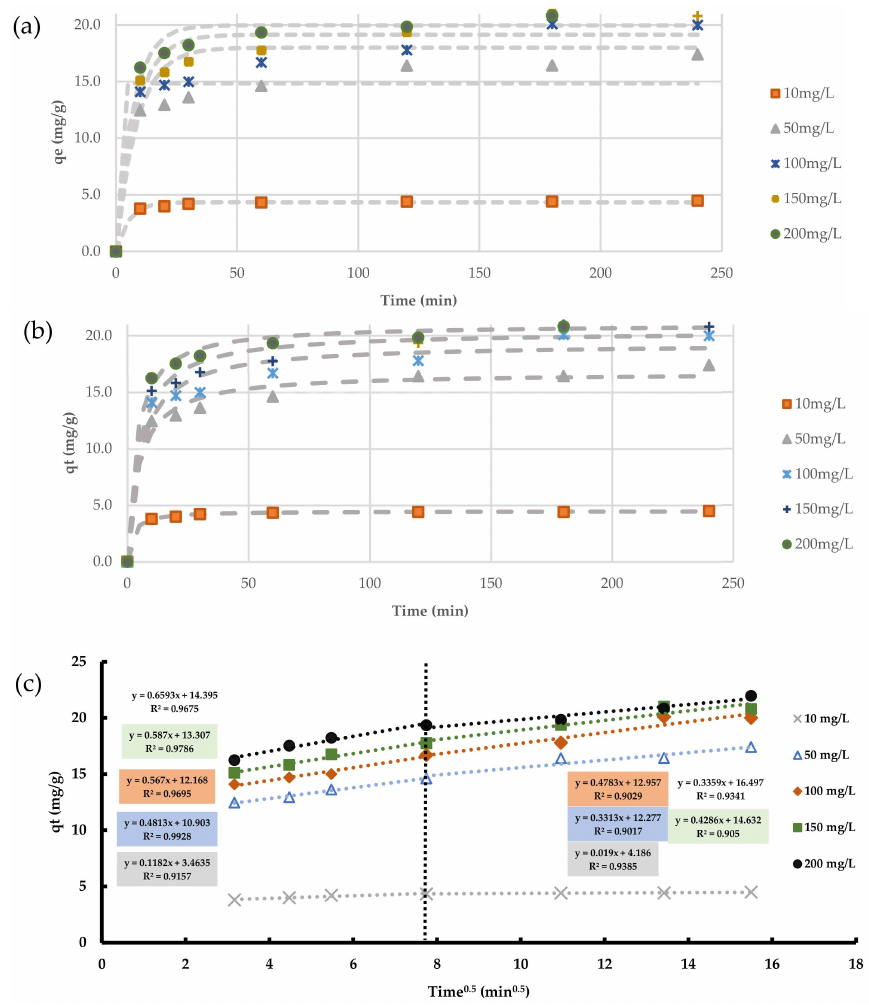
Figure 12. Asorption kinetics: ( a ) Pseudo first order ( b ) Pseudo second order ( c ) intra-particle diffusion